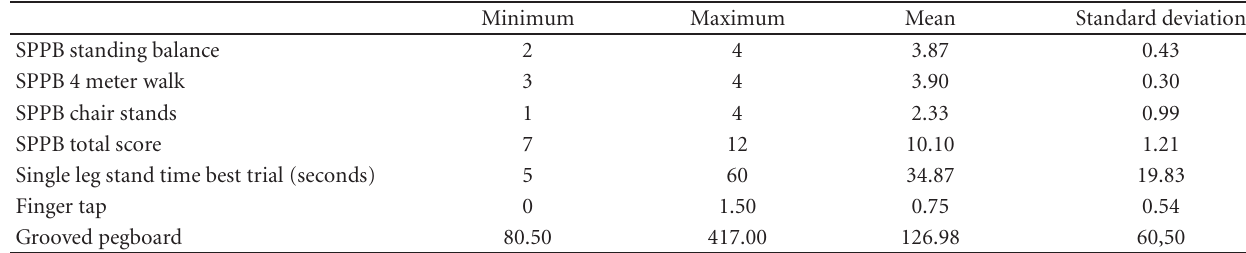
Table 1: Motor performance